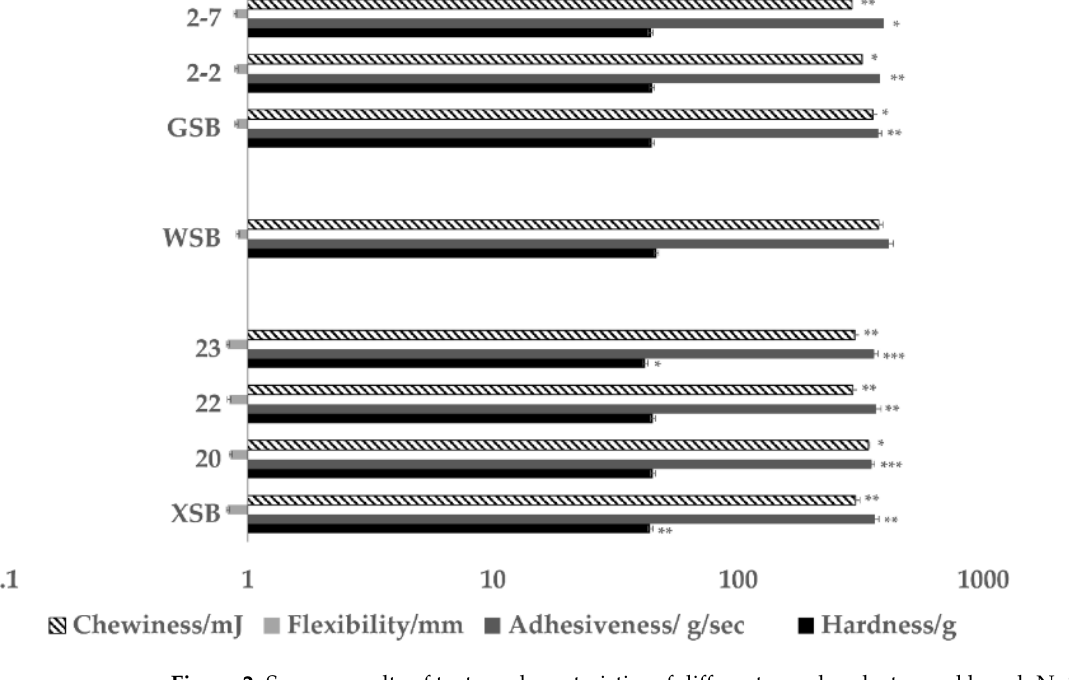
Figure 2. Survey results of texture characteristics of different sourdough steamed bread. Note: a *, **, and *** indicate significance at P = 0.05, 0.01, and 0.001, respectively.